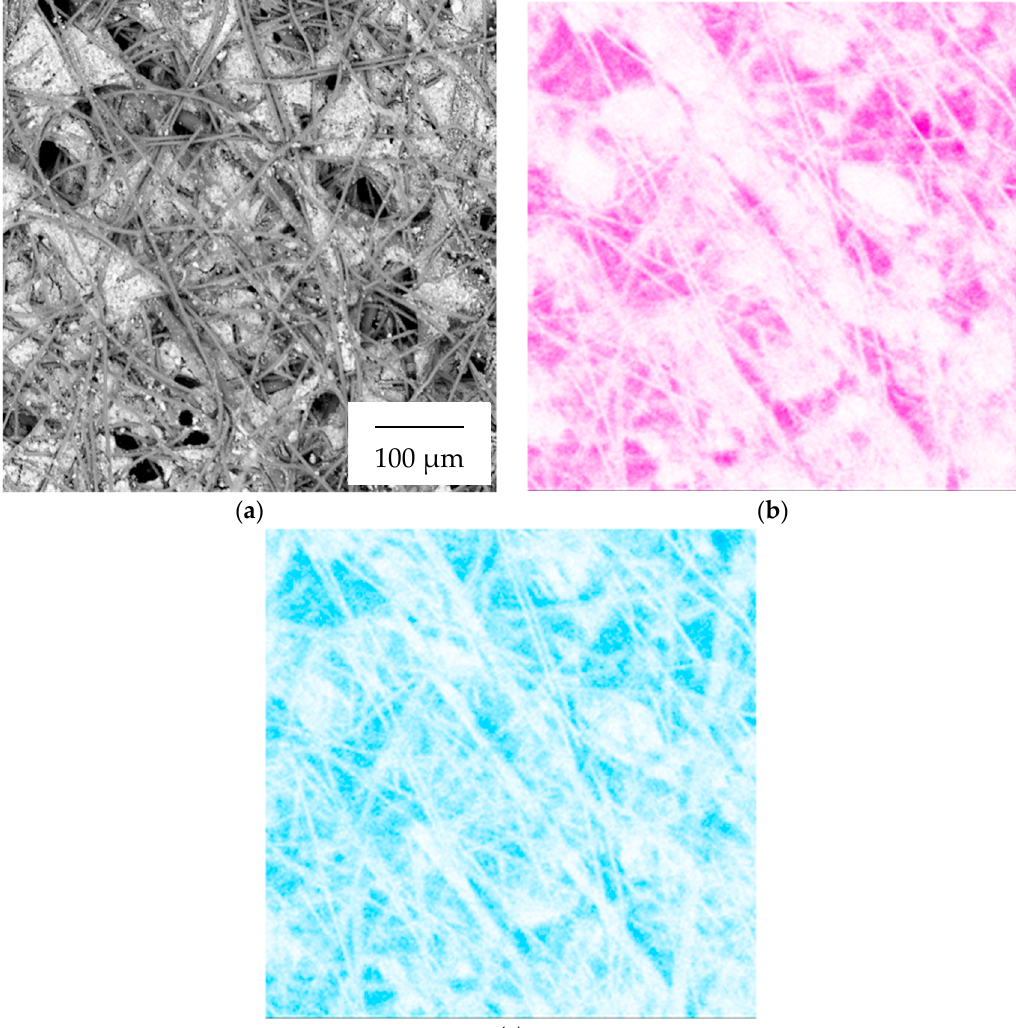
Figure 1. Scanning electron microscopy-energy dispersive X-ray spectroscopy (SEM-EDS) mapping images of TiO 2 /zeolite composite sheet: SEM images ( a ); EDS mapping of Si ( b ) and Ti ( c ).